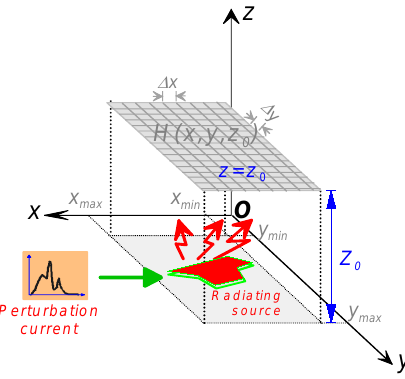
Figure 3: Representation of the magnetic NF scanned in the plane placed at the height z 0 above the radiating